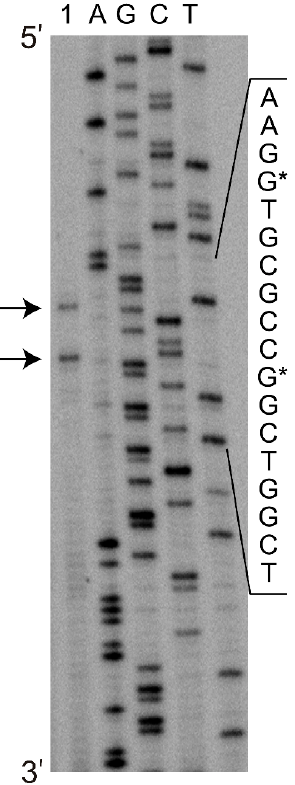
Figure 3. Determination of the transcription start site by primer extension analysis using the total RNA from R. jostii TMP1 harbouring the pART3-5 ′ UTR-gfp plasmid. The extended product was analysed alongside a DNA sequencing reaction, using the same primer. The transcription initiation sites are indicated by arrows, and the corresponding nucleotides in the DNA sequence are marked by asterisks. Two 15 nt repeats (box A, − 79 to − 65; and B, − 51 to − 37) (Figure 4b) with 13 nt spacing, and two short 7 nt inverted repeats (box C, − 45 to − 39; and D, − 34 to − 28) were detected by visual inspection